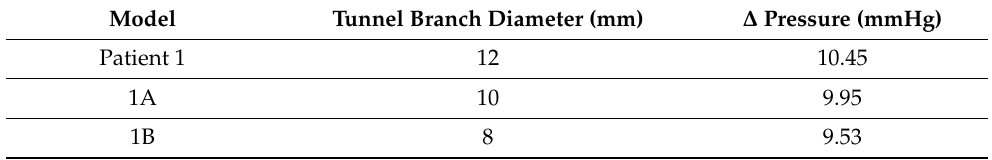
Figure 3. Comparison of instantaneous velocity streamlines obtained for Patient 1 and Patient 2 at three characteristic time points in the cardiac cycle. Table 1. Pressure drop across the endograft for different tunnel branch